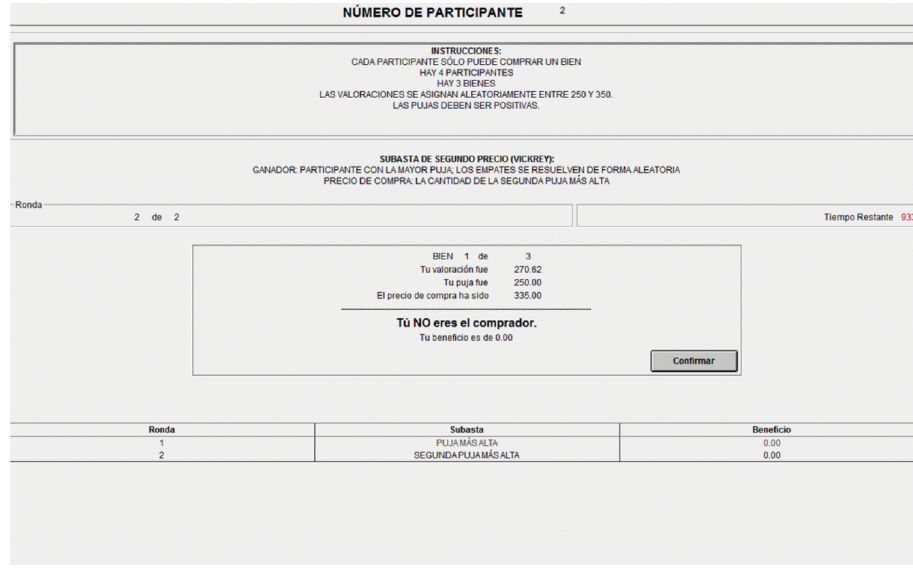
Figure A1.7. Non-winner of